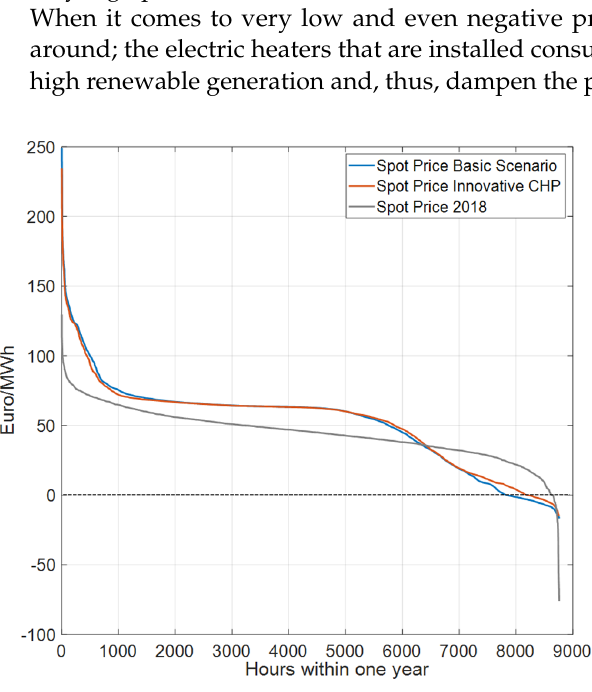
Figure 8. Annual duration curve of electricity prices in the year 2035. Price are derived in the simulation as described in Section 2.2.2 and based on the parameter assumptions in Section 2.1. The number of negative prices [52] is reduced from 922 in the base scenario to 586 in the InnoCHP